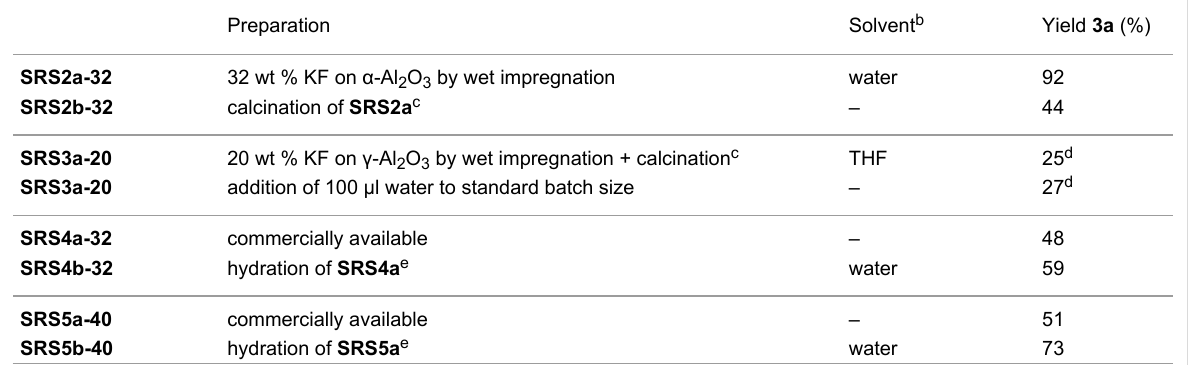
Table 5: Influence of different solid reaction systems ( SRS ) on the yield of the Suzuki–Miyaura reaction a of phenylboronic acid ( 1 ) with p -bromo- acetophenone ( 2a ; Scheme 1).